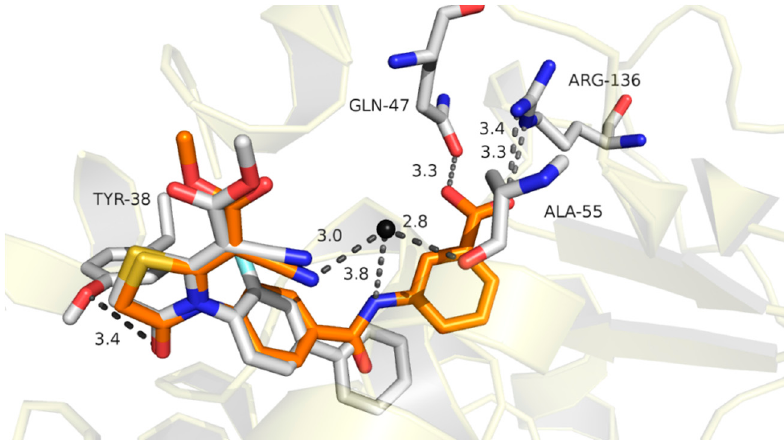
Figure 6. Proposed binding mode of benzamide-substituted 4-thiazolidinones as h DHODH inhibitors (orange sticks: compound 41 , gray sticks: compound 10 ).